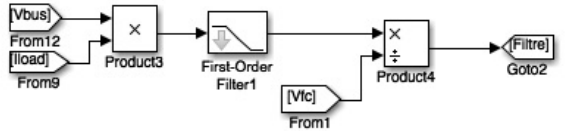
Figure 17. Generation of the reference of the FC current: simulation block diagram. Before entering in the simulation of the power-train at different SOC levels, the different components of the circuit need to be sized, and the control system